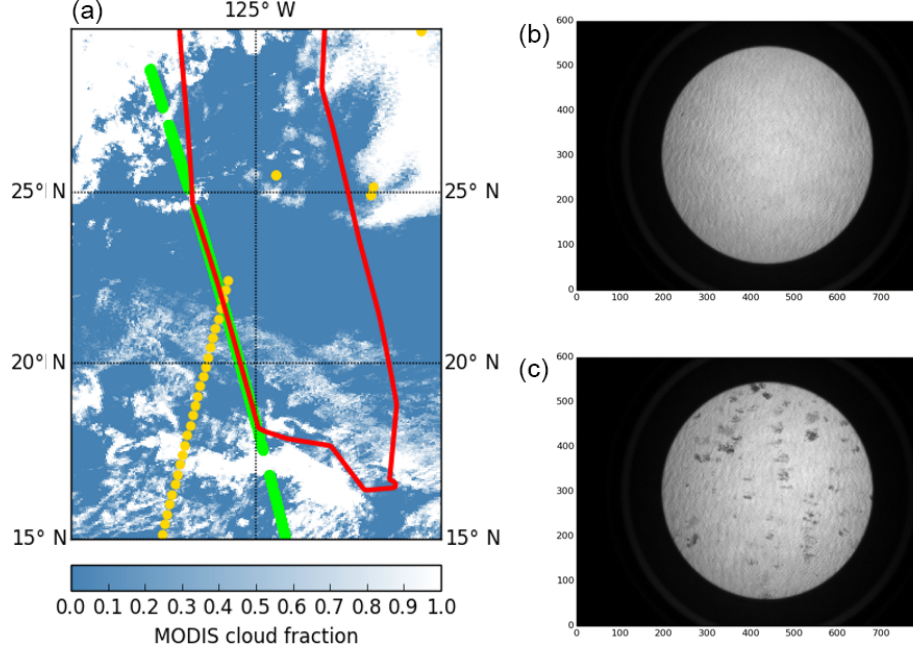
Figure 18. (a) 10 March Global Hawk flight path (red) plotted with sample locations of OCO-2 (green) and GOSAT (yellow) soundings. The blue–white colour scale shows the cloud fraction retrieved from MODIS (Moderate Resolution Imaging Spectroradiometer) observations. (b, c) Images from the GHOST visible camera taken during the OCO-2 overpass. Panel (b) shows cloud-free conditions towards the beginning of the flight leg, whilst (c) shows sparse cloud cover encountered towards the end of the flight